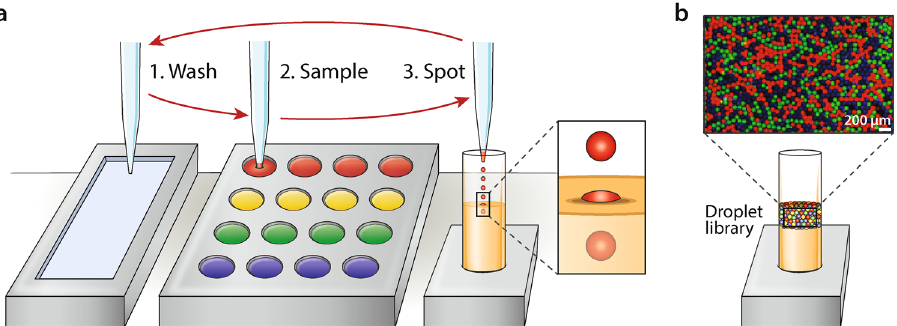
Figure 1. Automated liquid handling and dispensing with commercial drop in air printer for generation of monodisperse droplet libraries. ( a ) Each sample is emulsified by operating the printer’s capillary nozzle in a three-step cycle. 1. The nozzle moves to the wash tray and the previous contents in the nozzle are ejected; 2. The nozzle moves to the sample plate and suctions several microliters of sample; 3. The nozzle moves to the oil bath and ejects droplets into an oil bath, after which it moves to the wash tray. ( b ) Droplet libraries generated in this fashion are monodisperse and analogous to those generated by a microfluidic